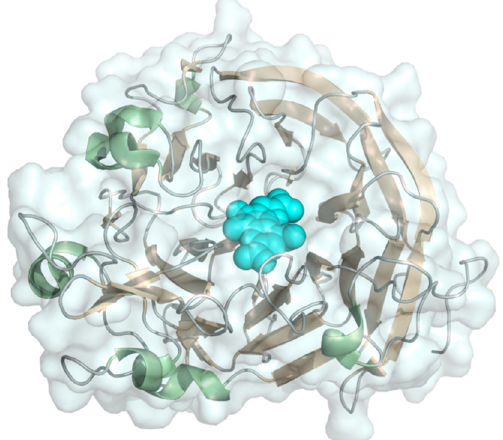
Figure 9. Crystal structure of the dehydrogenase domain of Coprinopsis cinerea PQQ-dependent pyranose dehydrogenase (PDB: 6JWF) with the PQQ cofactor rather exposed to the protein surface.